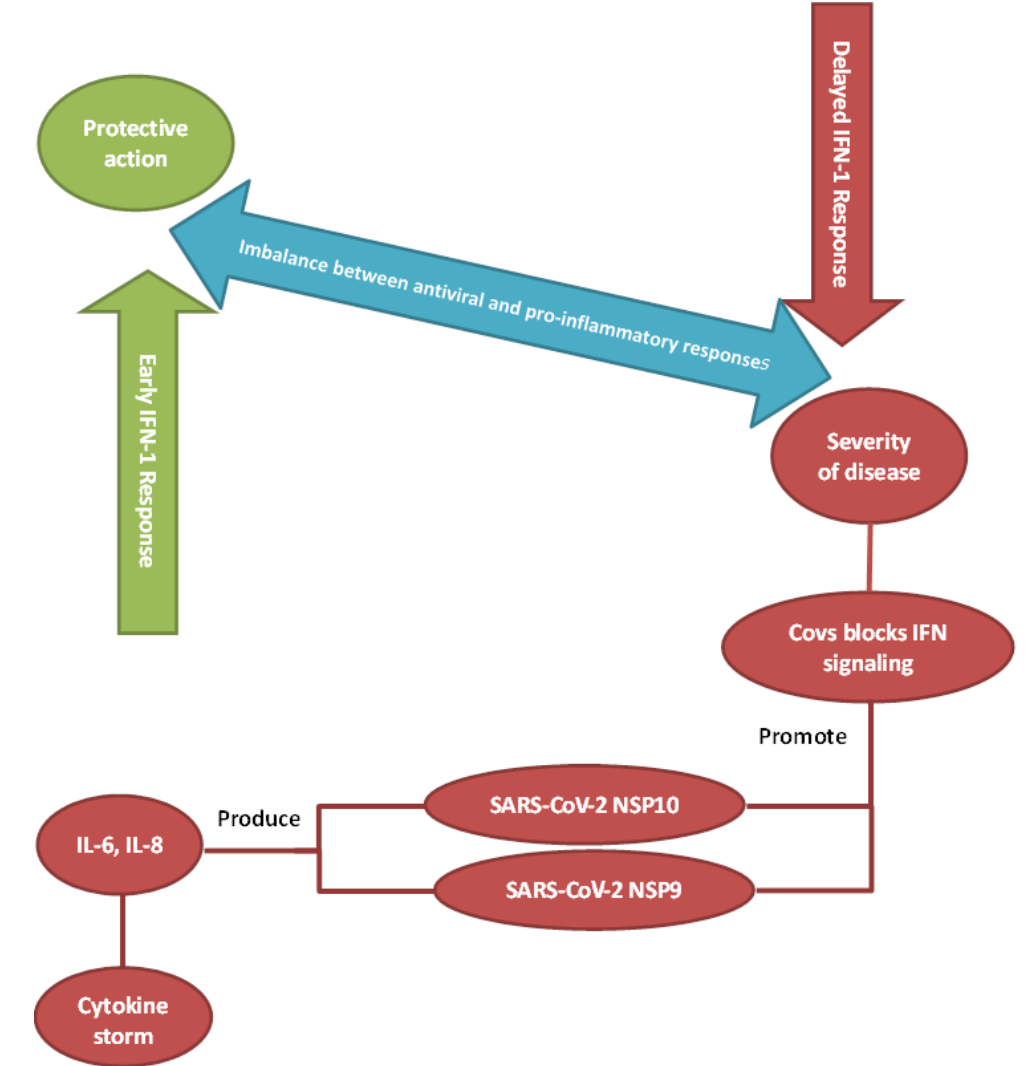
Figure 2. Imbalance between antiviral and proinflammatory responses. Insufficient or inappropriately-timed activation of interferon signaling may play a significant role in disease progression to severe COVID-19.